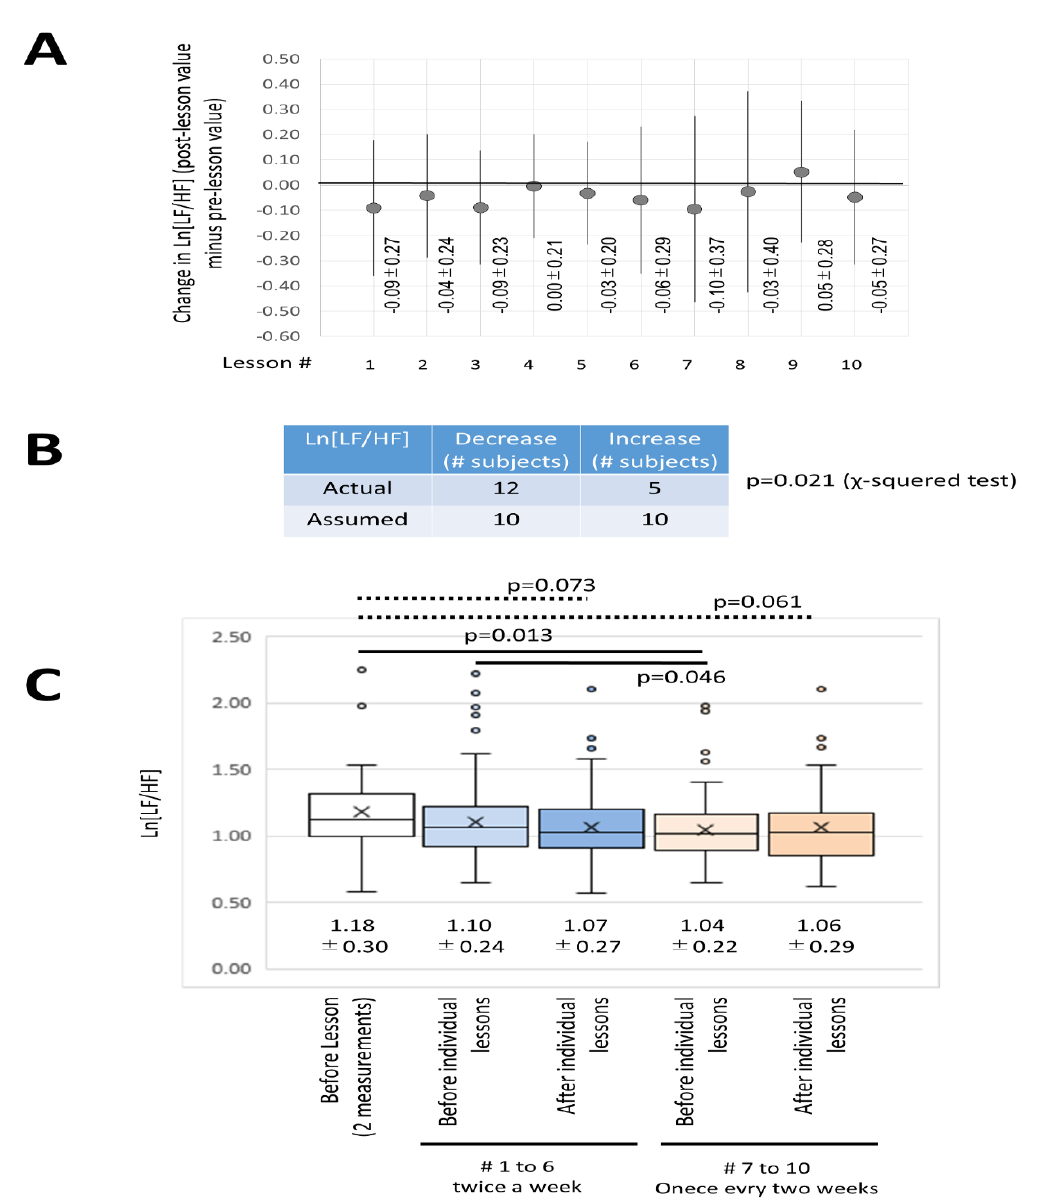
Figure 8. The e ff ect of the DHPM on autonomic balance. ( A ) Average value of changes in Ln[LF / HF] of the 20 subjects in 10 lessons (post-value minus pre-value). The values declined except in the case of lessons 4 and 9. ( B ) Chi-squared test assuming that the results of panel A are predicted to have a decline in half and a rise in half. There were many subjects that showed a significant decrease ( p = 0.018). ( C ) In the 10 lessons of the 20 subjects, 12 subjects showed decreased Ln[LF / HF] more often after the lesson than before the lesson, 3 subjects remained unchanged, and 5 subjects showed increased Ln[LF / HF]. A chi-squared test was performed with half of the expected change decreasing and half increasing. Many subjects showed significant decreases ( p = 0.021). ( D ) In an e ff ort to observe the long-term e ff ects of the DHPM, the average, median, and distribution of Ln[LF / HF] of the 20 subjects are shown using a box and whisker plot. From the left, 2 measured values before entering the lesson (row 1), followed by the 1st to 6th measurements, that is, before (row 2) and after (row 3) the lesson when the lesson (the initial (intense) period) is performed twice a week (6 lessons total) and the value before the lesson (row 4) and after value (row 5) of the 7th to 10th lessons (one lesson every 2 weeks, 4 lessons total: the final (more relaxed) period). The solid line indicates the significant di ff erence ( p < 0.05), and the dotted line indicates the trend (0.1 > p >